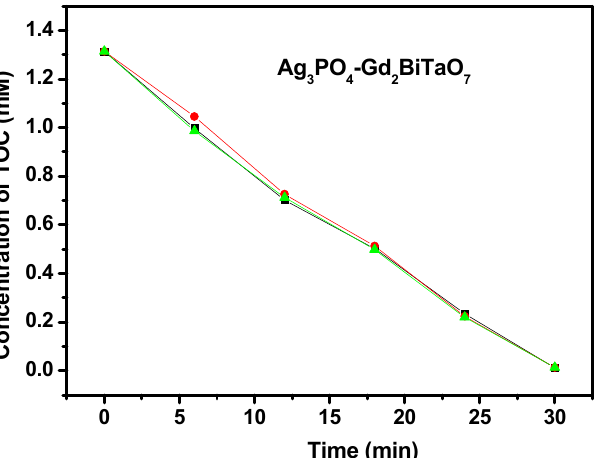
Figure 17. Concentration variation curves of total organic carbon during photocatalytic degradation of bisphenol A in pharmaceutical wastewater with Ag 3 PO 4 /Gd 2 BiTaO 7 heterojunction as photocatalyst under visible light irradiation for three cycle degradation tests.